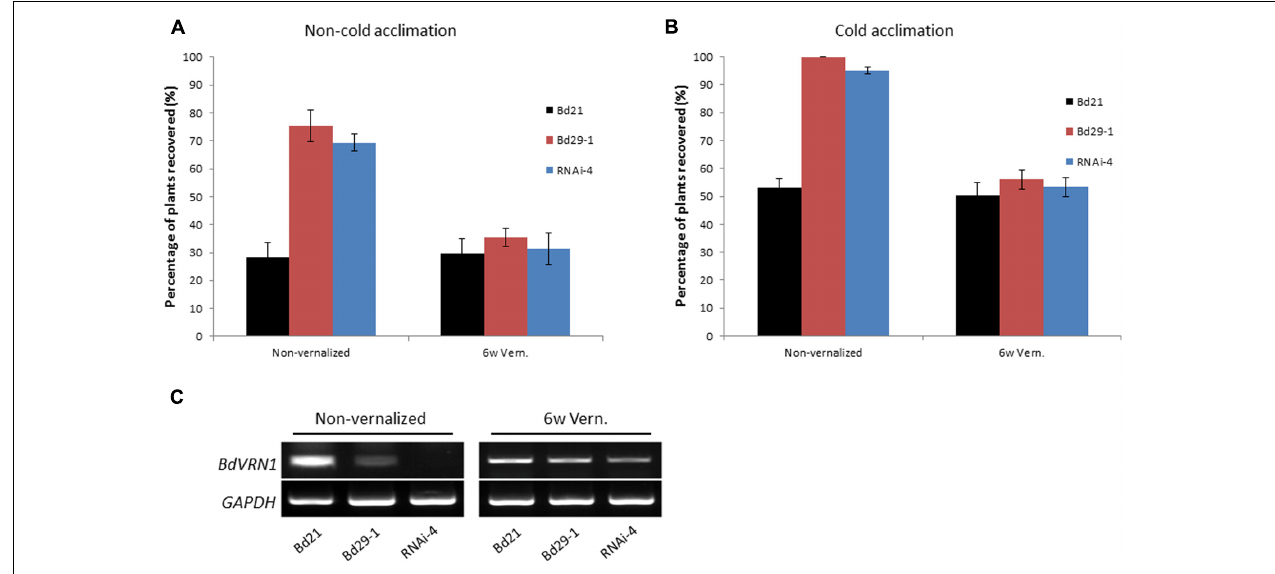
FIGURE 5 | Freezing tolerance of vernalized or non-vernalized Bd21 and Bd29-1 with or without cold acclimation. (A) Freezing tolerance of non-vernalized or vernalized plants of Bd21, Bd29-1, and BdVRN1 mutant RNAi-4 without cold acclimation. Freezing tolerance was assayed by subjecting plants to –5 ◦ C and 8/16 h (day/night) for 12 h in a growth chamber. Plants were then moved back into a greenhouse (25 ◦ C, 16/8 h day/night) and were examined for recovery a week later. The non-vernalized plants were 5-week-old. (B) Freezing tolerance of non-vernalized or vernalized plants of Bd21, Bd29-1, and RNAi-4 mutant following a 10 day cold acclimation. (C) Semiquantitative RT-PCR of BdVRN1 gene in leaves from vernalized or non-vernalized plants of Bd21, Bd29-1, and RNAi-4 mutant. Leave tissues were collected before assessing freezing tolerance for each accession. Error bars represent the standard deviation from independent plants.